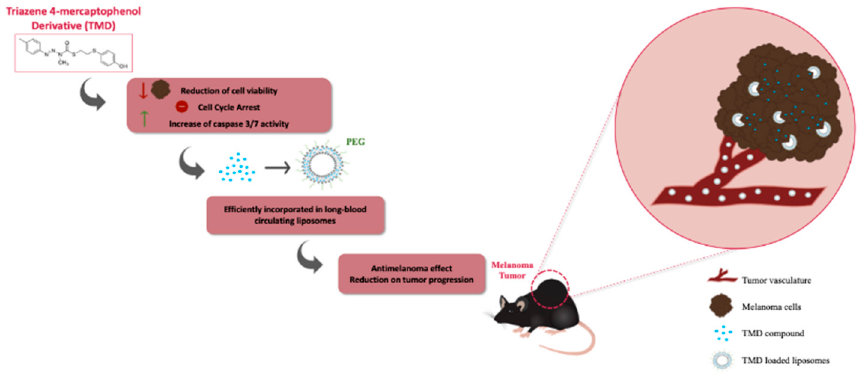
Figure 1. Schematic representation of the present Figure 20. Schematic representation of the present study.